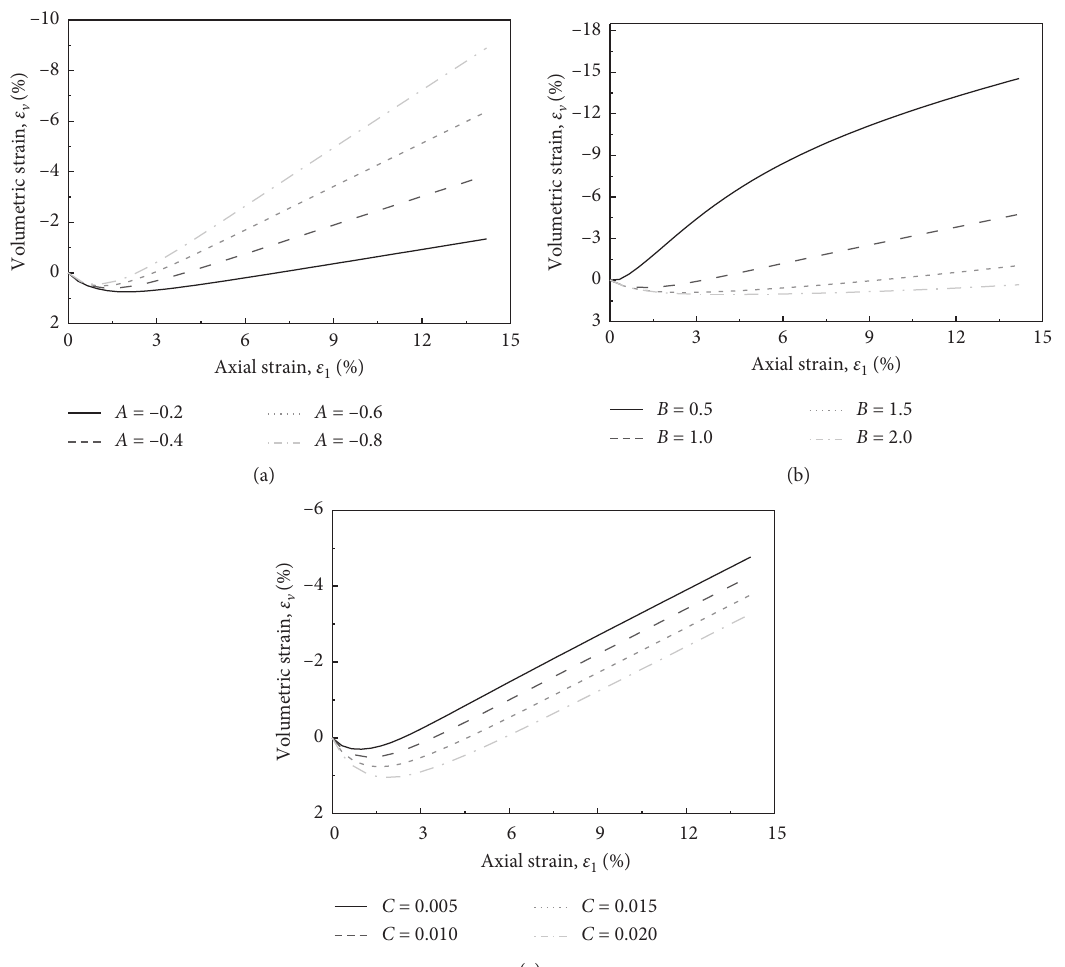
Figure 17: Volumetric strain curves for different values of parameters (a) A , (b) B , and (c) C